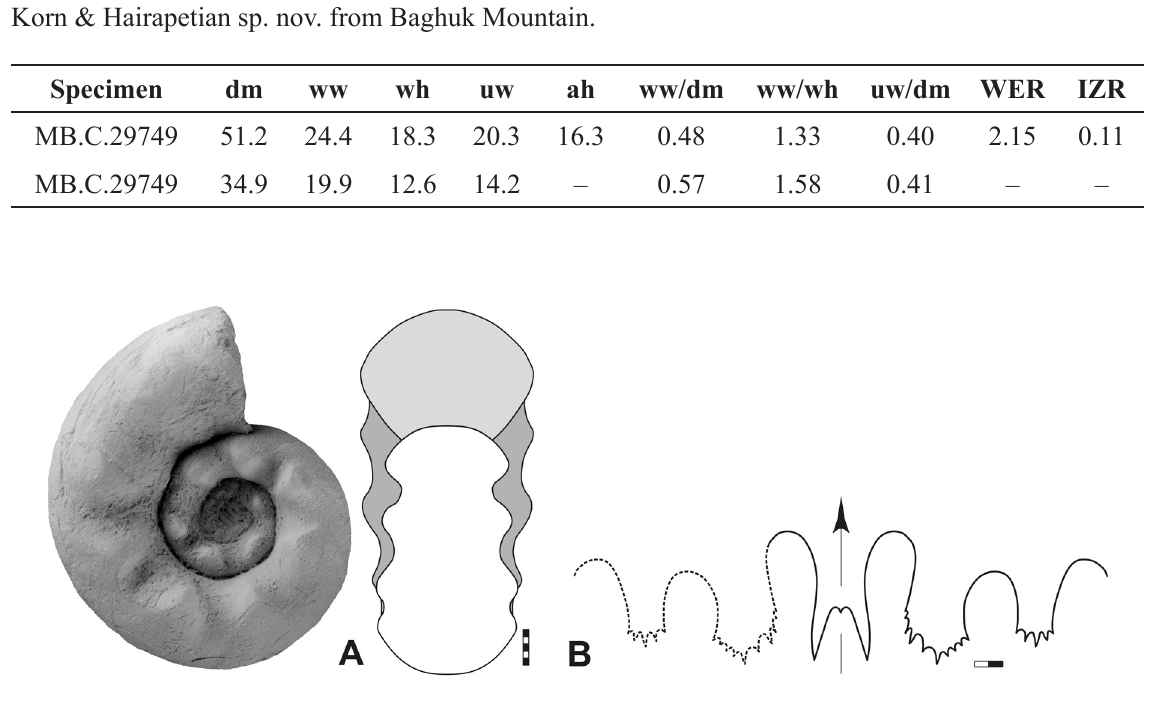
Fig. 24. Paratirolites rubens Korn & Hairapetian sp. nov. A . Lateral and dorsal view, holotype MB.C.29749, section E, float. B . Suture line, holotype MB.C.29749, at 36.0 mm dm, 22.0 mm ww, 13.0 mm wh. Abbreviations: see Material and methods. Scale bar units = 1 mm.